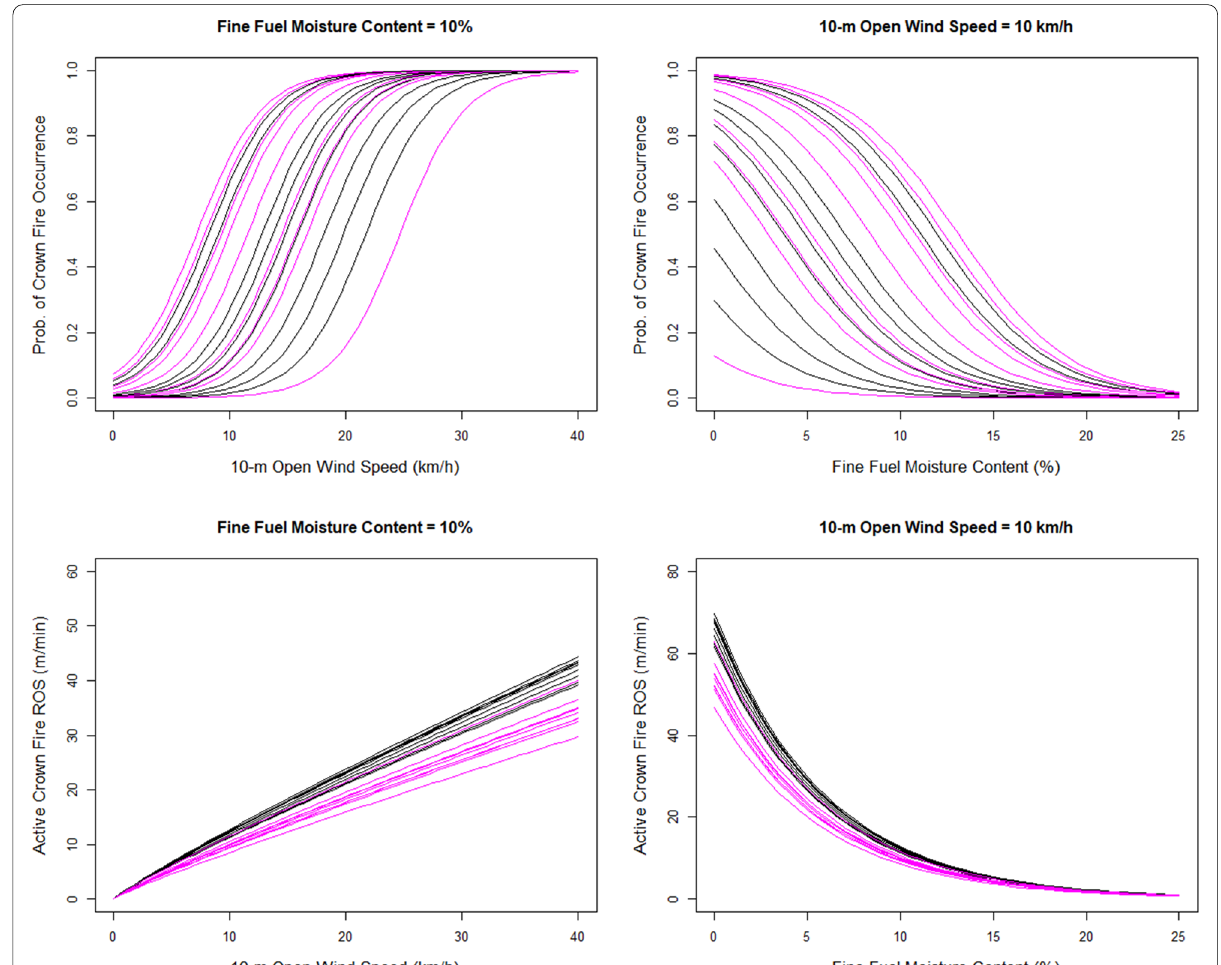
Fig. 9 Plots of the probability of crown fire occurrence and active crown fire rate of spread (ROS) for untreated stands that were originally in the Black fuel class cluster (FCC) (black) and these same stands after being treated